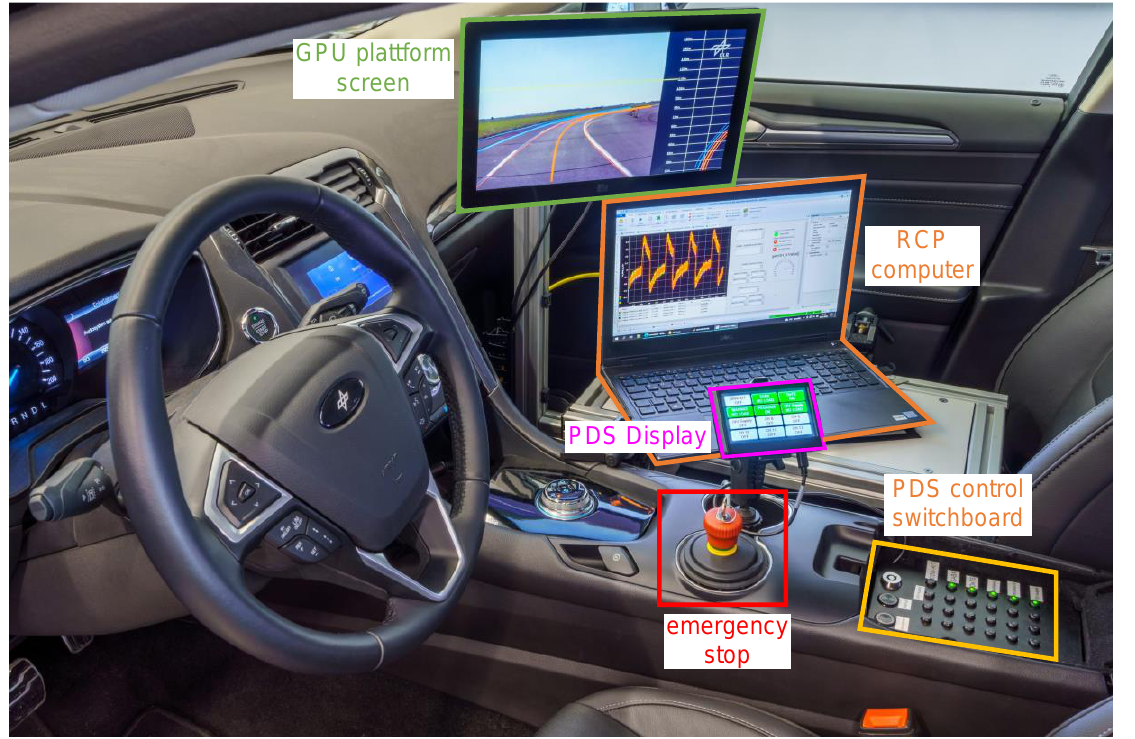
Figure 7. AFM’s front cabin—central vehicle operation and monitoring from the driver’s